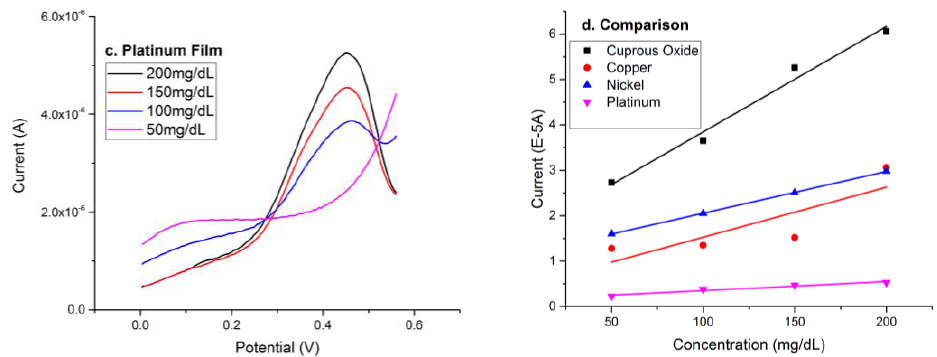
Figure 9. Detection response based on different metal films ( a ) copper, ( b ) nickel, ( c ) platinum, ( d ) comparison.